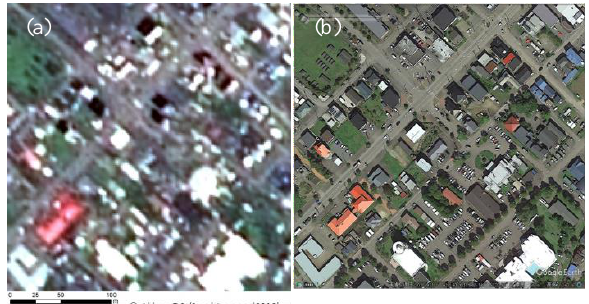
Figure 1 . (a) Image taken on 2018/09/11 with ground resolution (GR) 1.5m (b) respective aerial image taken at same location on 2018/09/11 with 0.1m GR. 1